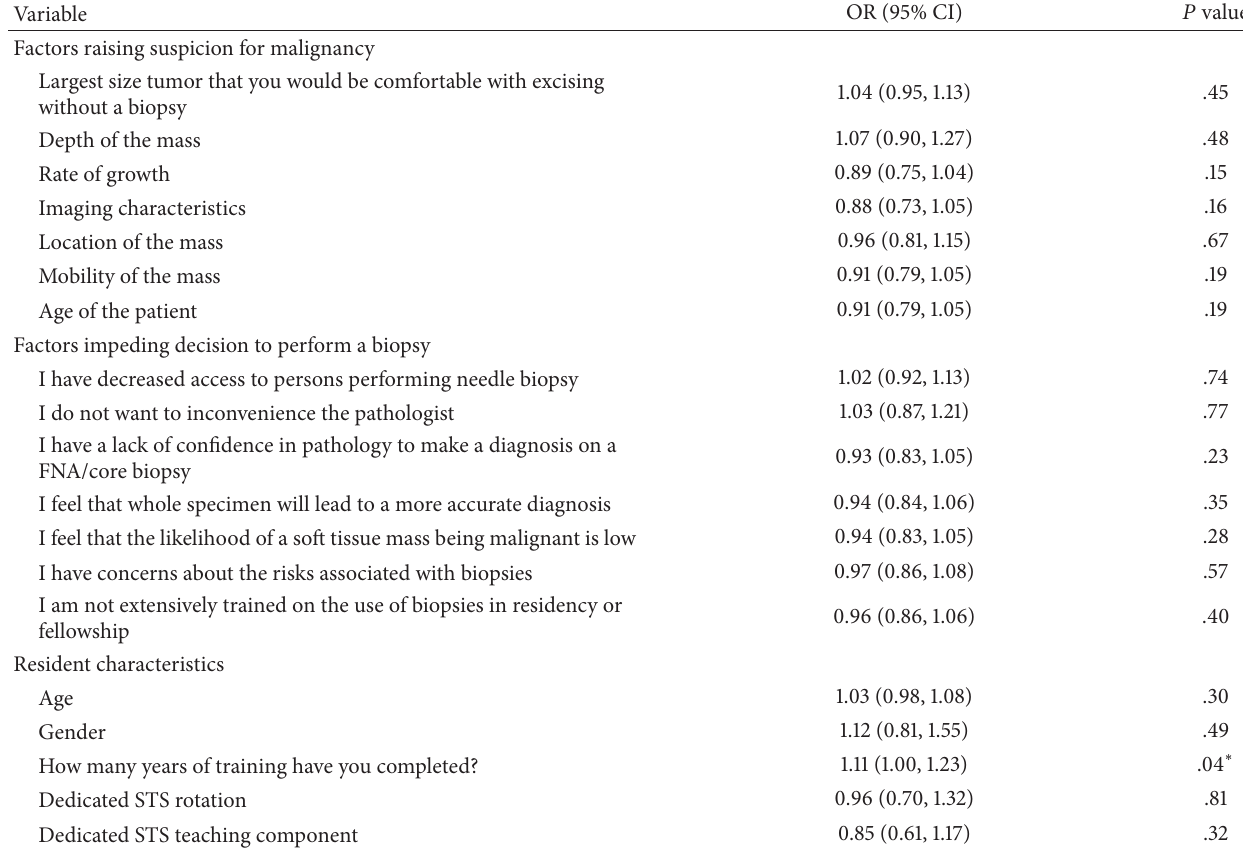
Table 5: Bivariate analyses for selecting correct clinical decision for general surgery